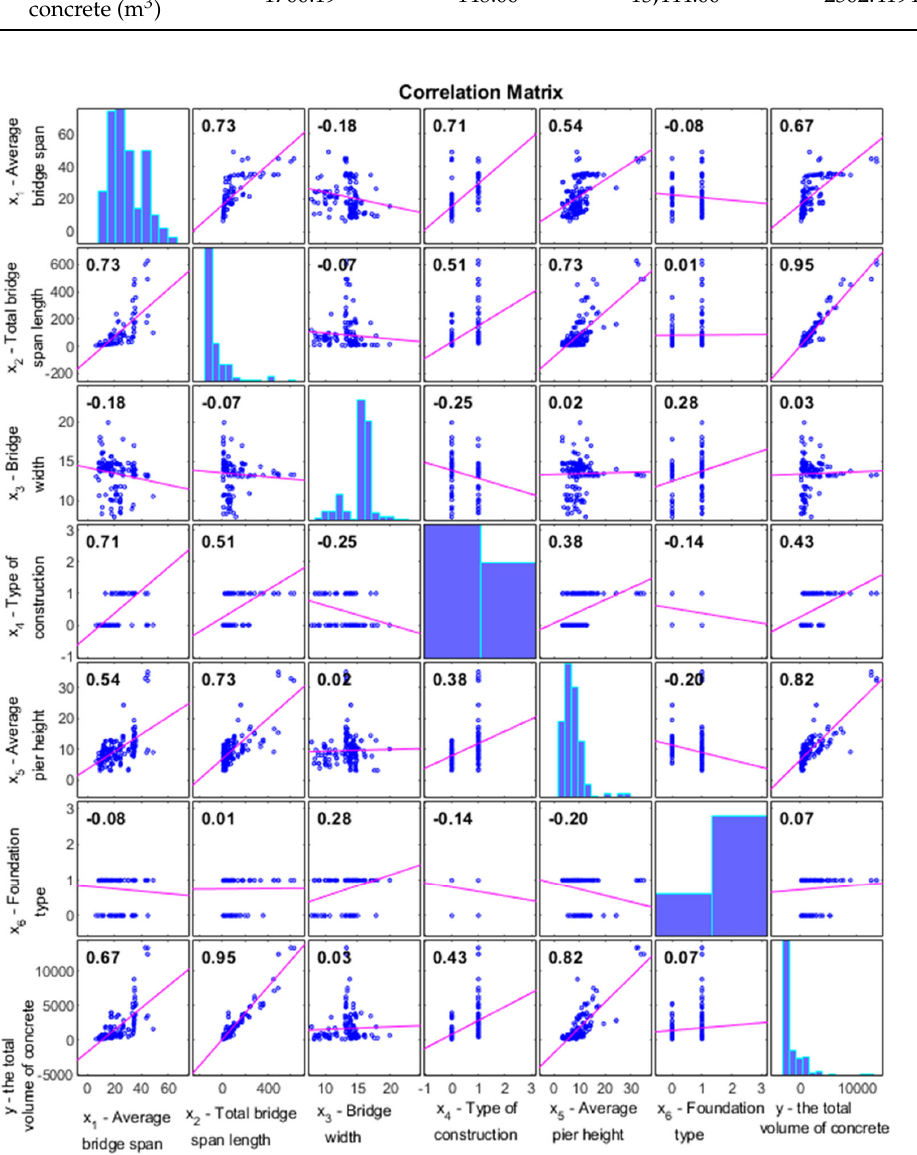
Figure 7. Correlation matrix with histograms of variables. Criteria for Assessing Model